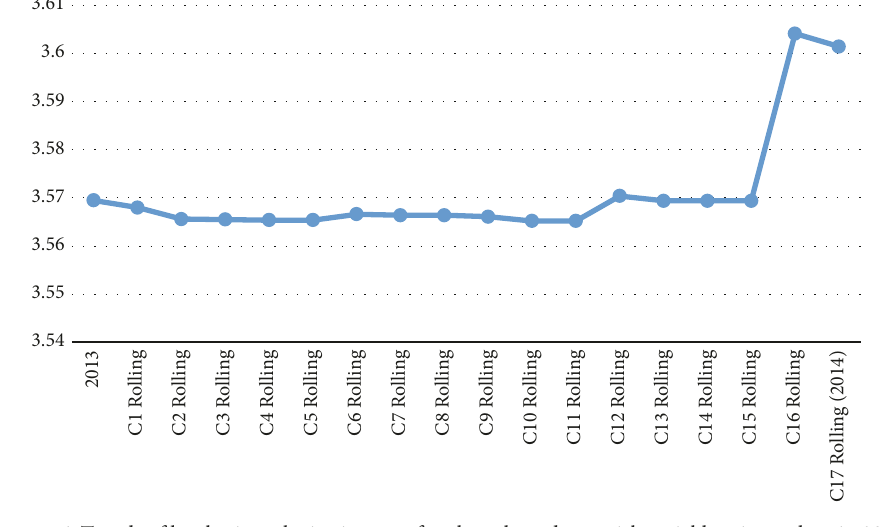
Figure 6: Trends of level-wise substitution set of each evaluated metarisk variables eigenvalues in